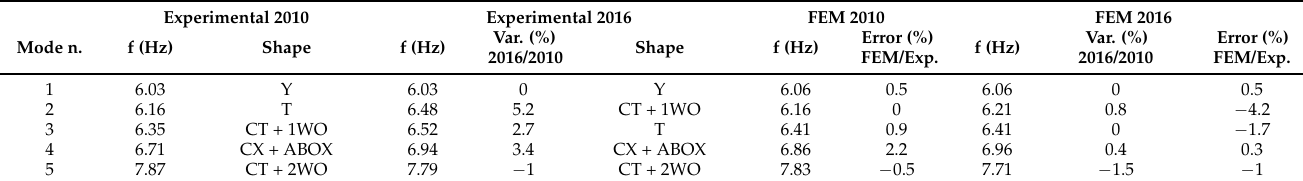
Table 1. Natural frequencies (f) of the first 5 modes obtained with the experimental modal analysis and comparison with the numerical simulations. Shape: Y = mainly translational in Y, T = torsional, CT + 1WO = torsional (building C) + one wing opposing CT, CX + ABOX = mainly translational in X (building C) + X translation in opposite directions (both wings), CT + 2WO = torsional (central portion) + both wings opposing CT. X and Y positive directions are reported in Figure 4. FEM 2010: model updated using 2010 data. FEM 2016: modification of FEM 2010 to reproduce the effects of 2012